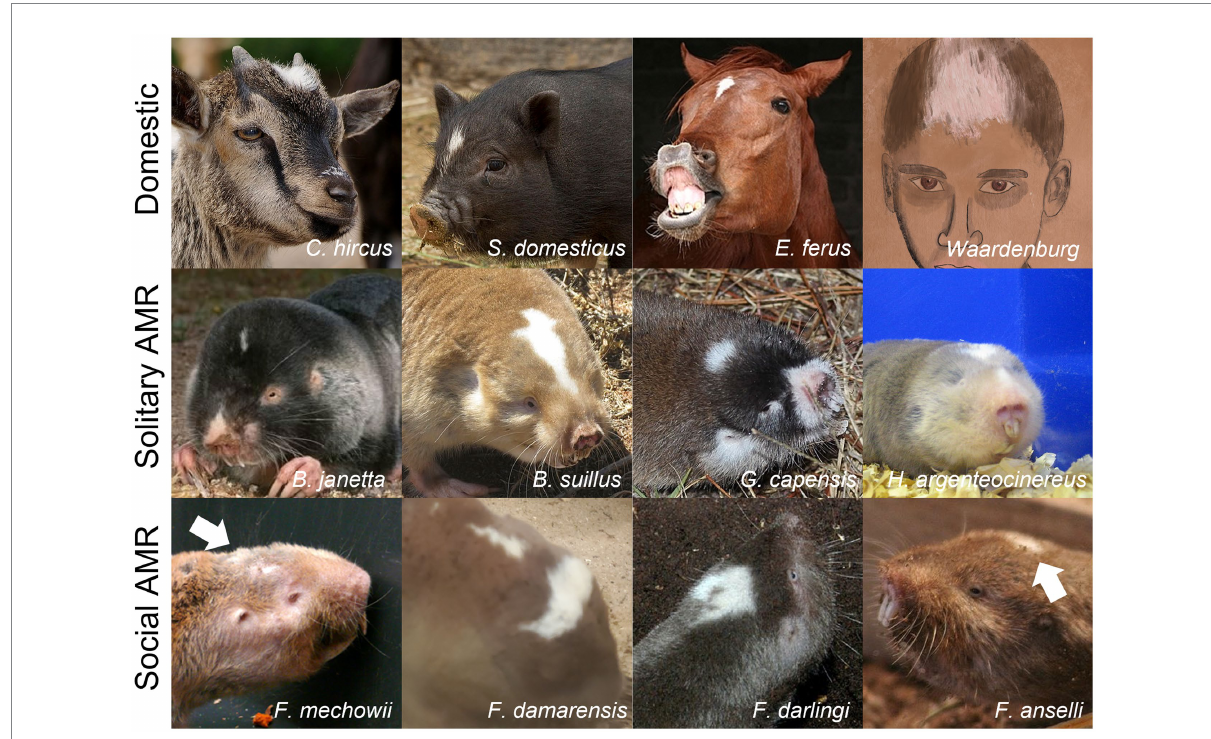
FIGURE 2 White forehead patch in domestic species and African mole rats. Domestic species and some neurocristopathies are associated with large white patches on the forehead. Most African mole-rats present a white forehead patch which size and frequency could be associated with their